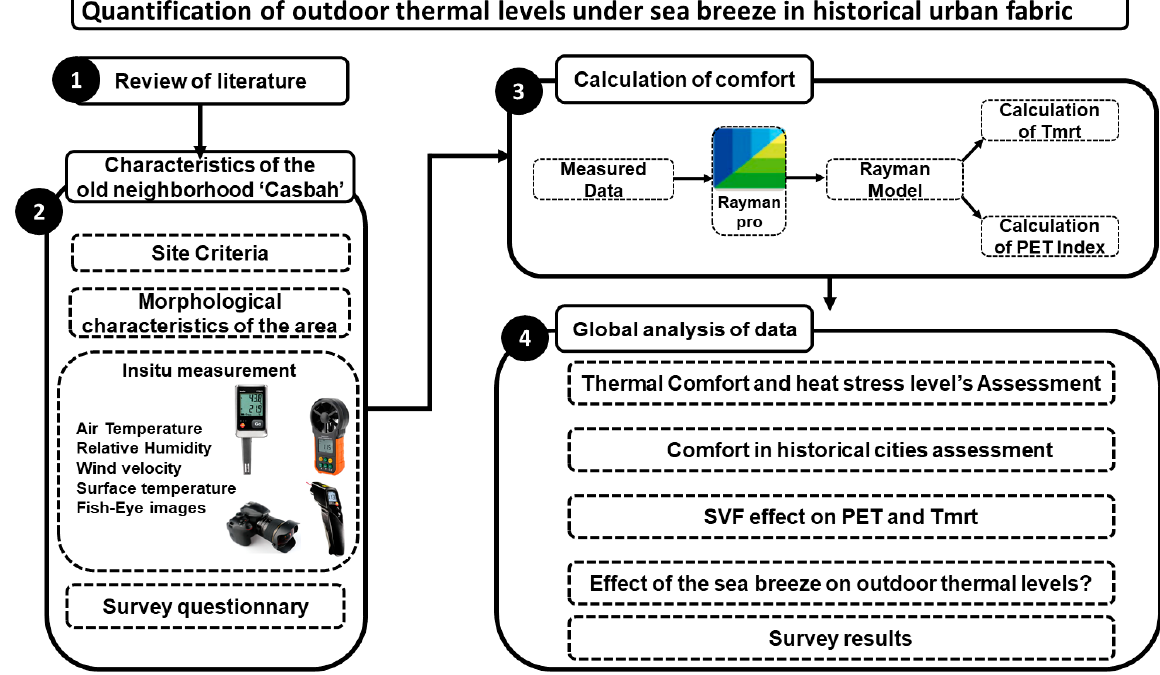
Figure 2. Study conceptual framework.